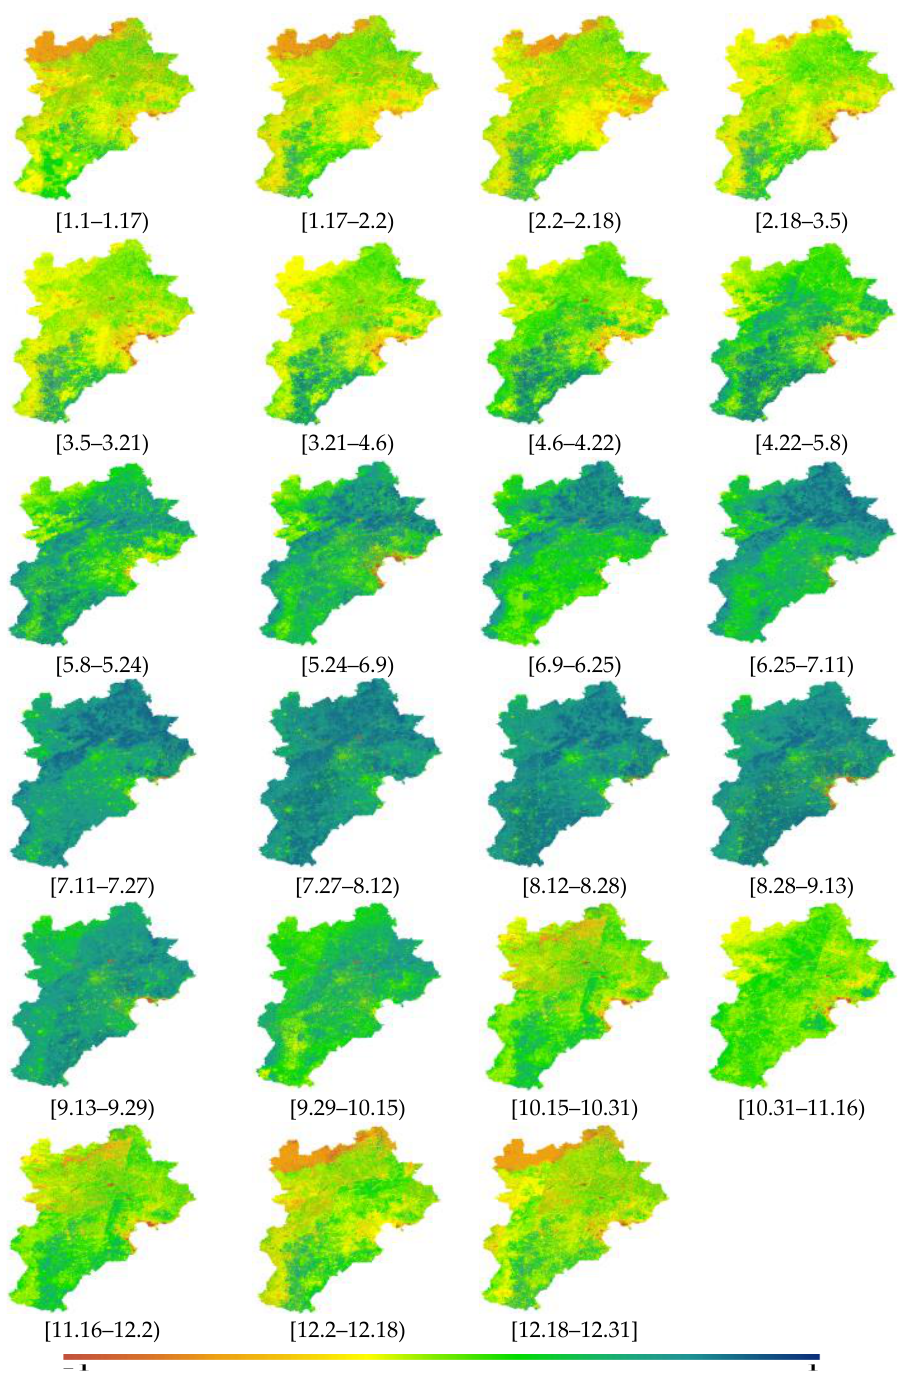
Figure 10. Spatial changes in NDVI for Beijing – Tianjin – Hebei.